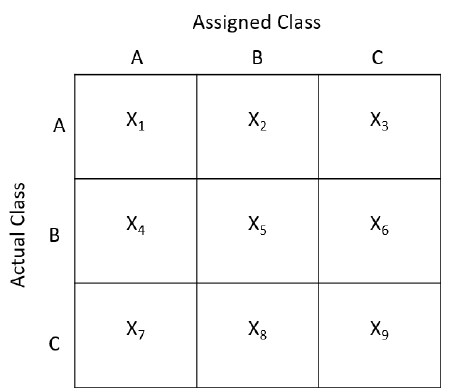
Figure 5. Confusion Matrix for multiclass classification.